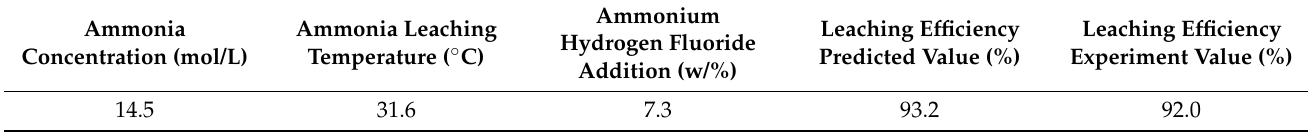
Table 5. Optimization process parameters of the regression